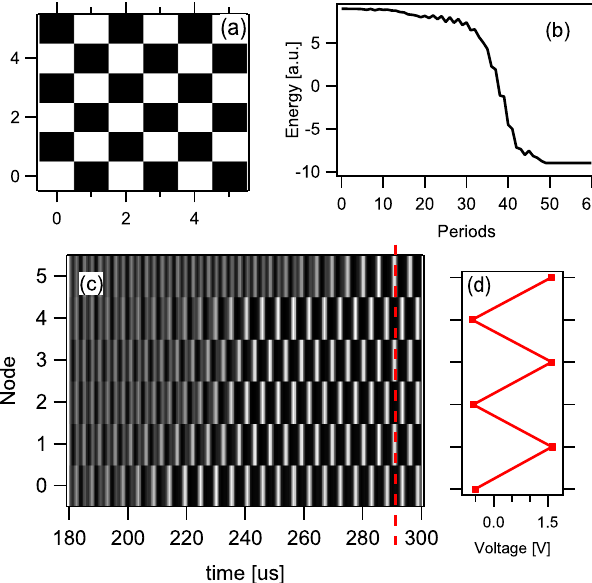
Fig. 3 Experimental evolution to unique ground state. a The coupling matrix for N = 6 Möbius-ladder graph, where black (white) squares represent negative (zero) coupling. b The time evolution of the system ’ s energy, settling at the ground-state energy of E = − 9 after around 50 subharmonic periods. c the N = 6 circuit response — time is plotted on the horizontal axis, node number vertically, and the voltage response is depicted in gray-scale. d The voltage pro fi le encoding the ground state at particular instant of time, depicted as the red, dashed line in ( c ).